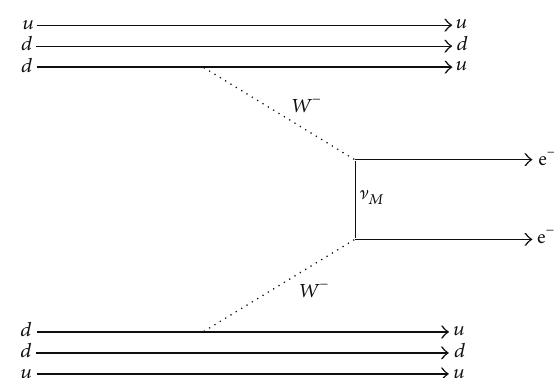
Figure 1: Diagram of the 0 ] 𝛽𝛽 process due to the exchange of massive Majorana neutrinos, here denoted generically by ] 𝑀